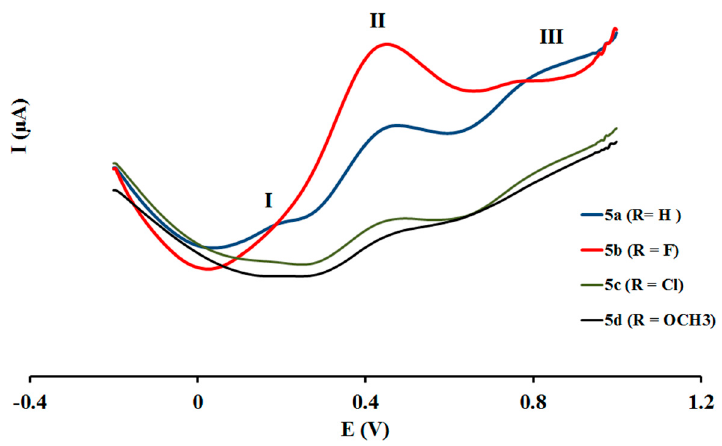
Figure 12. Square-wave voltammograms of (Ir( 5a – d ) 3 ) complexes.